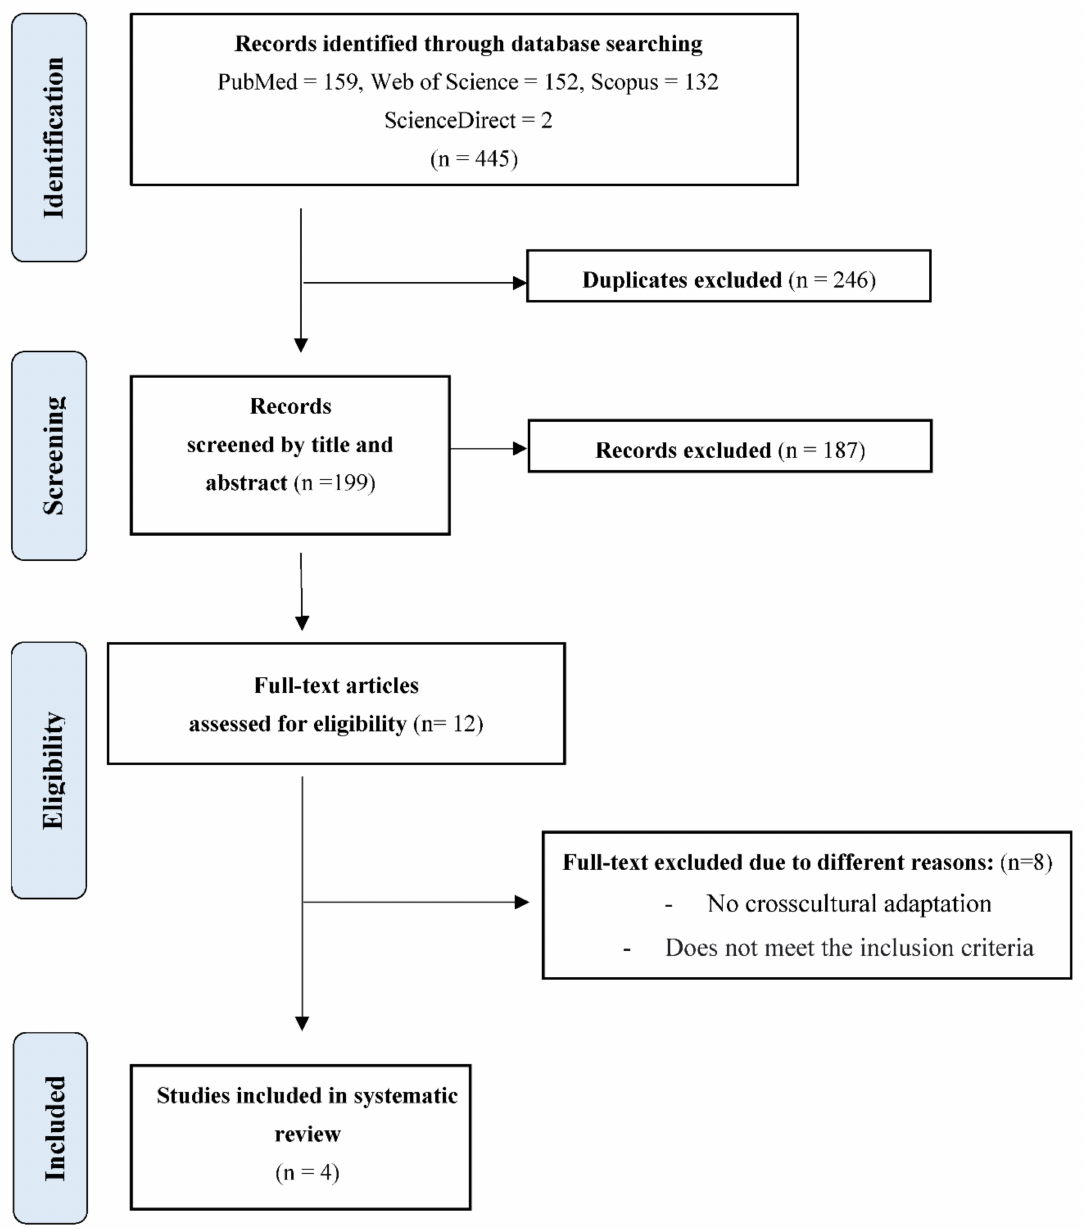
Figure 1. Flowchart for selecting studies based on